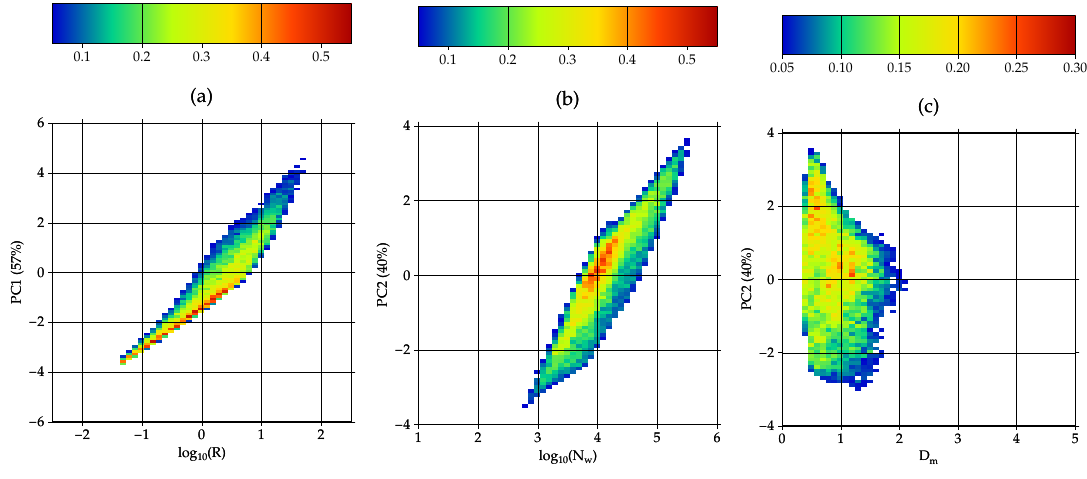
Figure 7. Number density (%) in the ( a ) log 10 R -PC1, ( b ) log 10 N w -PC2, and ( c ) D m -PC2